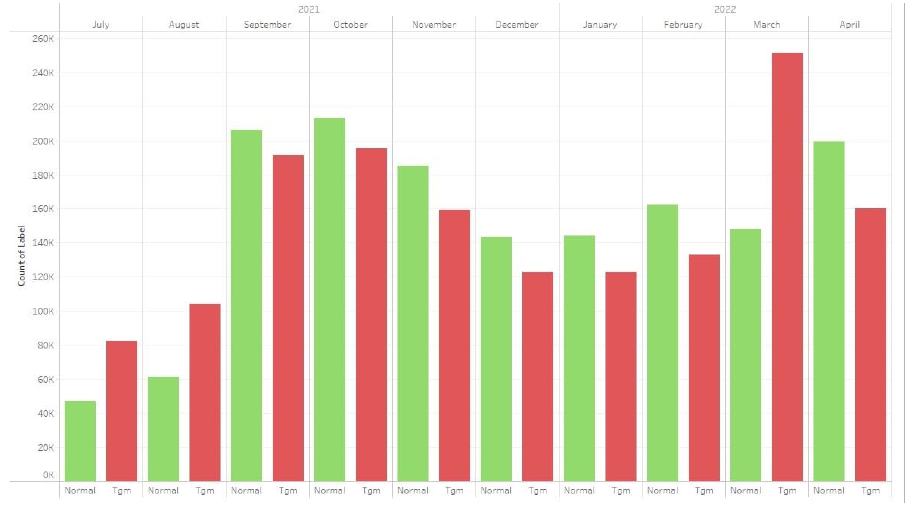
Fig. 2 Bar chart classification results each month